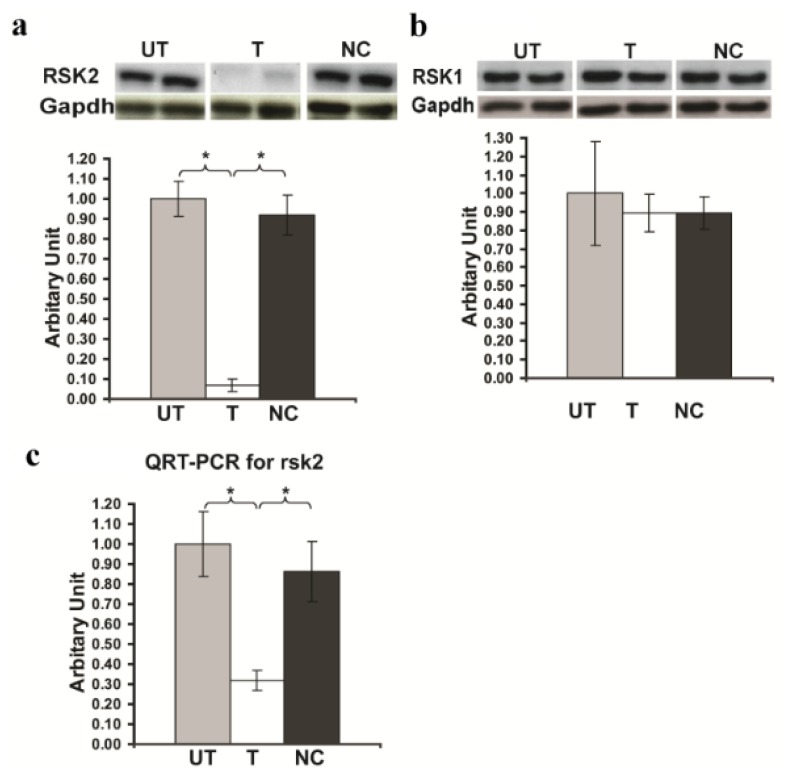
Silencing of the Rsk2 gene in PC12 cells. (A) Detection of the RSK2 protein level in Untransfected (UT), transfected with the Rsk2-shRNA (T) or the scrambled-shRNA (negative control, NC) PC12 cells. Data normalized to glyceraldehyde-3-phosphate dehydrogenase (GAPDH) are represented as the mean values ± SEM (UT: n > 8, T: n > 8, NC: n > 8). RSK2 expression is drastically decreased in Rsk2-shRNA transfected cells (*p < 0.05 by Student’s t-test). (B) RSK1 protein expression in PC12 cells. Western blots results showed no significant difference between UT, T and NC cells (UT: n > 3, T: n > 3, NC: n > 3). (C) Quantification of the expression level of the Rsk2 mRNA by real time QRT-PCR (T: n > 3, UT: n > 3, NC: n > 3). Data are normalized to the Gapdh gene expression. Bar represents the mean ± SEM. *p < 0.05 by Student’s t-test.